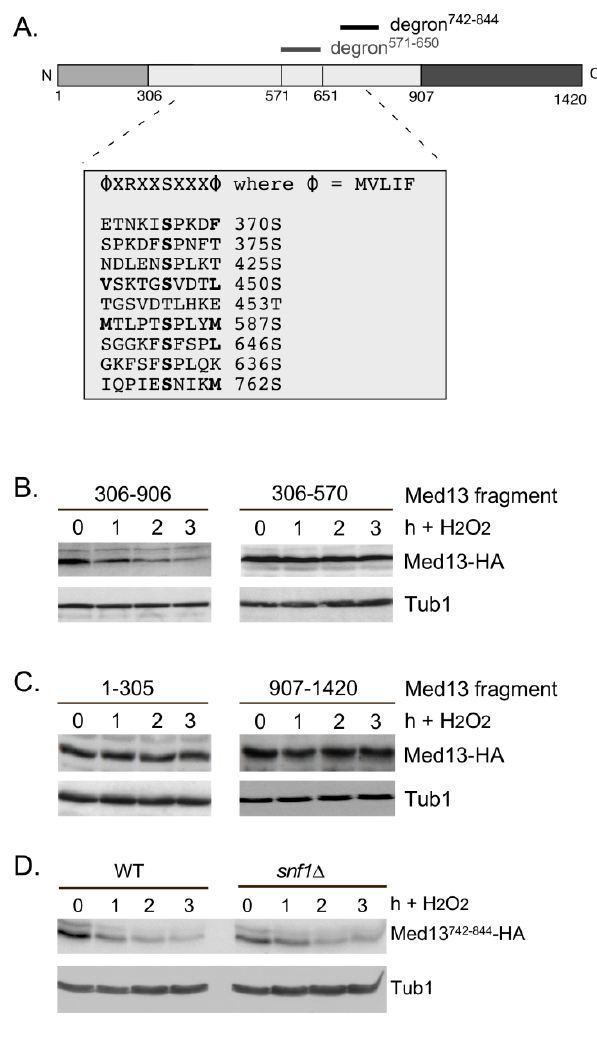
FIGURE 6: Other potential Snf1 sites in Med13 are not required for its degradation following H 2 O 2 stress. (A) Map of Med13 out- lying the positions of the two Med13 degrons, the consensus Snf1 target site [57] and potential Snf1 sites, identified by published proteomic screens. (B) and (C) Wild-type (RSY10) cultures harbor- ing the NLS-Med13-HA constructs shown were grown to mid-log phase (0 h) then treated with 0.4 mM H 2 O 2 for the indicated times. Med13-HA levels were determined by Western blot analy- sis. Tub1 levels were used as a loading control. (D) Mid-log wild type or snf1 ∆ cultures (RSY202) harboring HA tagged Med13 degron742-844 (pDS32) were subjected to an H 2 O 2 timecourse experiment and protein extracts analyzed by Western blot. Tub1 levels were used as loading